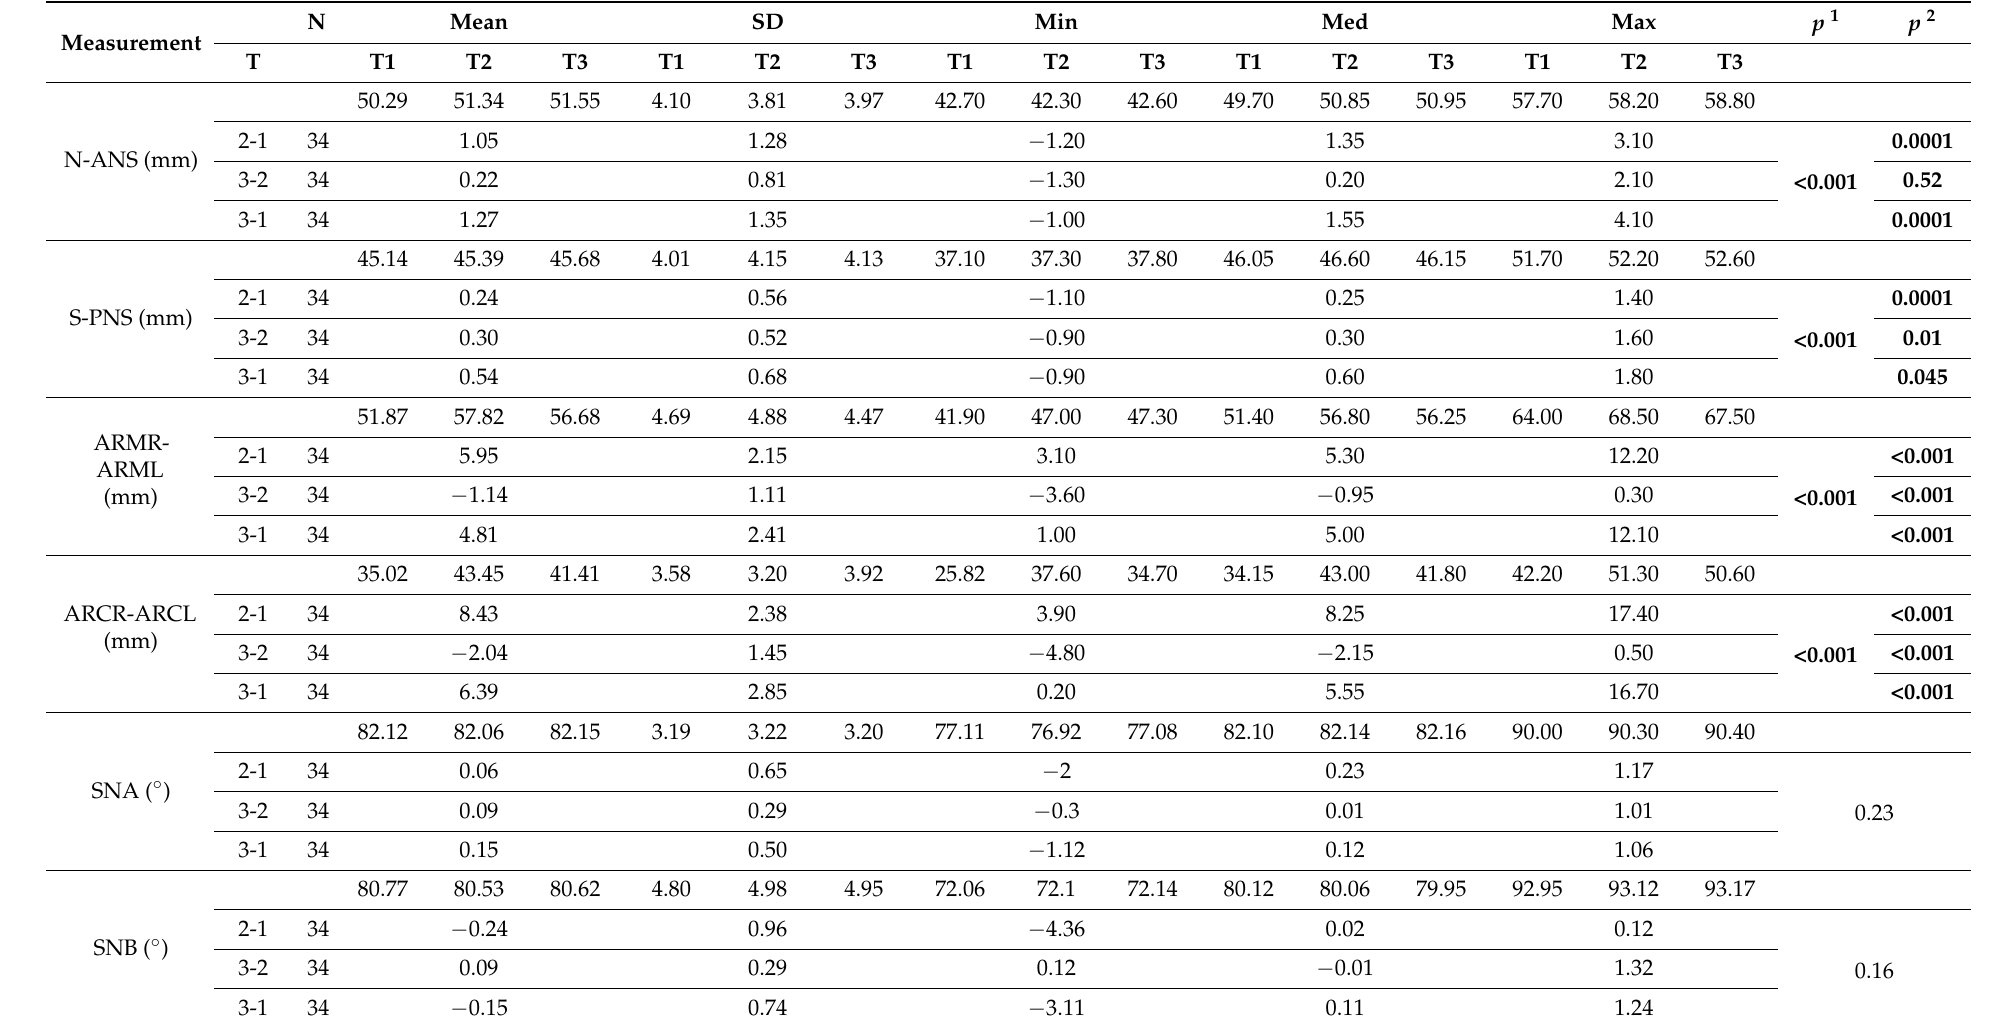
Table 1. Descriptive statistics of the linear and angular skeletal